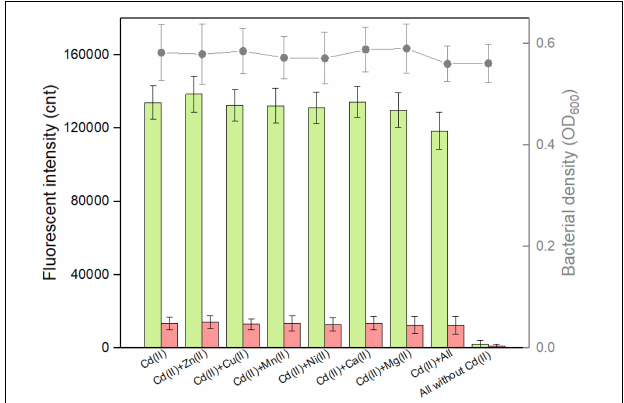
FIGURE 7 | Influence of responsive non-target Pb(II) and Hg(II) on the response of the dual-sensing biosensor toward Cd(II). Double-color fluorescence derived from TOP10/pCadC-G-CadR-R exposed to 5 µ M Cd(II) in the presence of increased concentrations of (A) Pb(II) and (B) Hg(II). After a 12-h incubation at 37 ◦ C, bacterial cell density was measured (point line diagram, right-Y scale), and both eGFP (green bars) and mCherry (red bars) fluorescence were determined (bar chart, left-Y scale). The fluorescence intensity ratios (eGFP/mCherry) were shown in the tables below the corresponding figures. The fluorescent signal was indicated as a fluorescence count value (unit = cnt), and fluorescence intensity values were normalized using the absorbance at 600 nm. The data values shown for each metal exposure group were obtained by subtracting the control values (with no metal exposure) from the experimental values. Results are the average of at least three independent experiments performed in